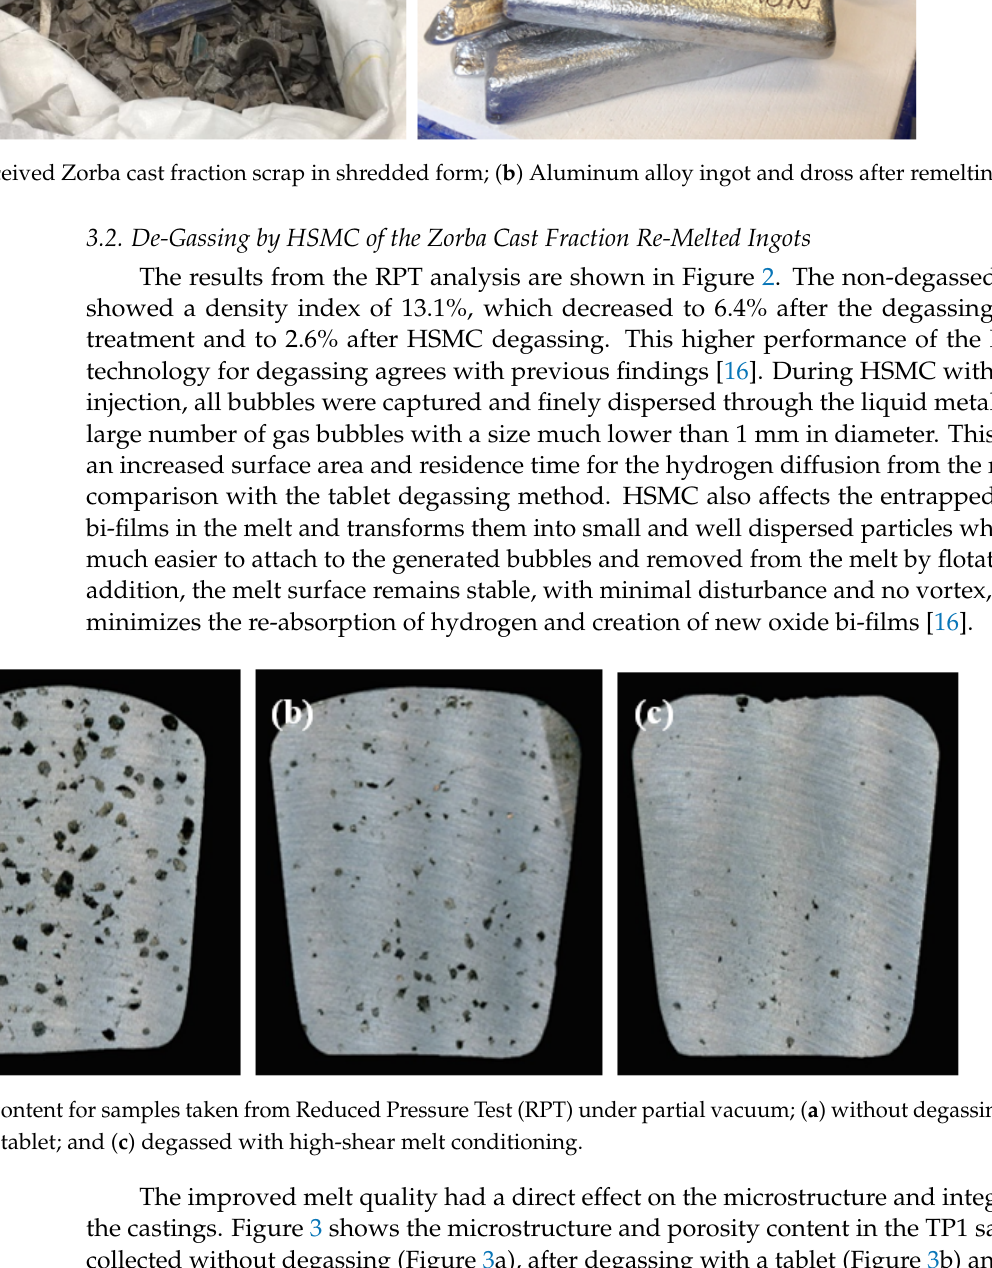
Figure 1. ( a ) As received Zorba cast fraction scrap in shredded form; ( b ) Aluminum alloy ingot and dross after remelt- ing. Table 1. Chemical composition of the aluminum alloy recovered from Zorba cast fraction compared with some typical commercial cast alloys. Wt.%